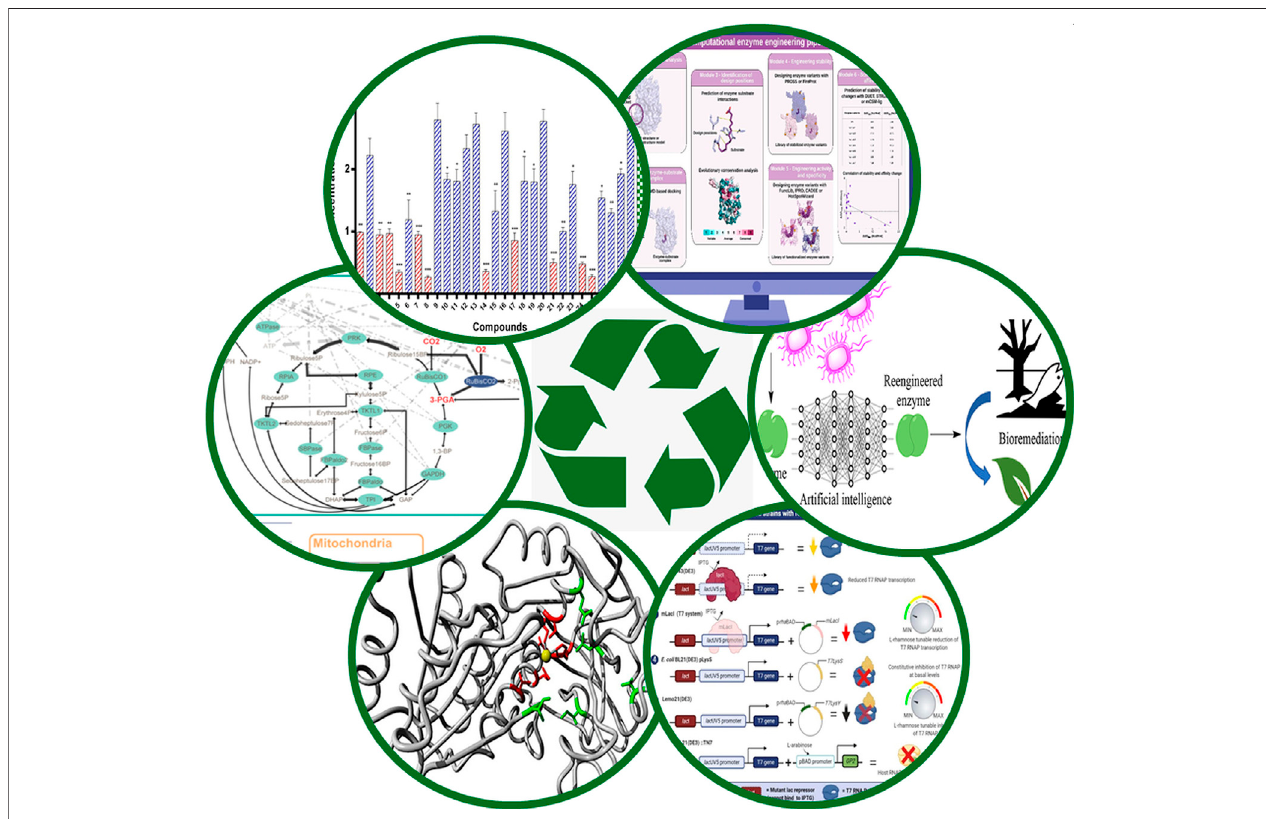
FIGURE1| Innovativestrategiesfromsyntheticbiologyandbacterialpathwaystomasterbiochemicalenvironmentalchallenges.Ourarticlecollectionofsixarticles gives a multi-facetted integrated picture on the involved pathways and engineering strategies (Figure: Courtesy of Dr. Elena Bencurova).